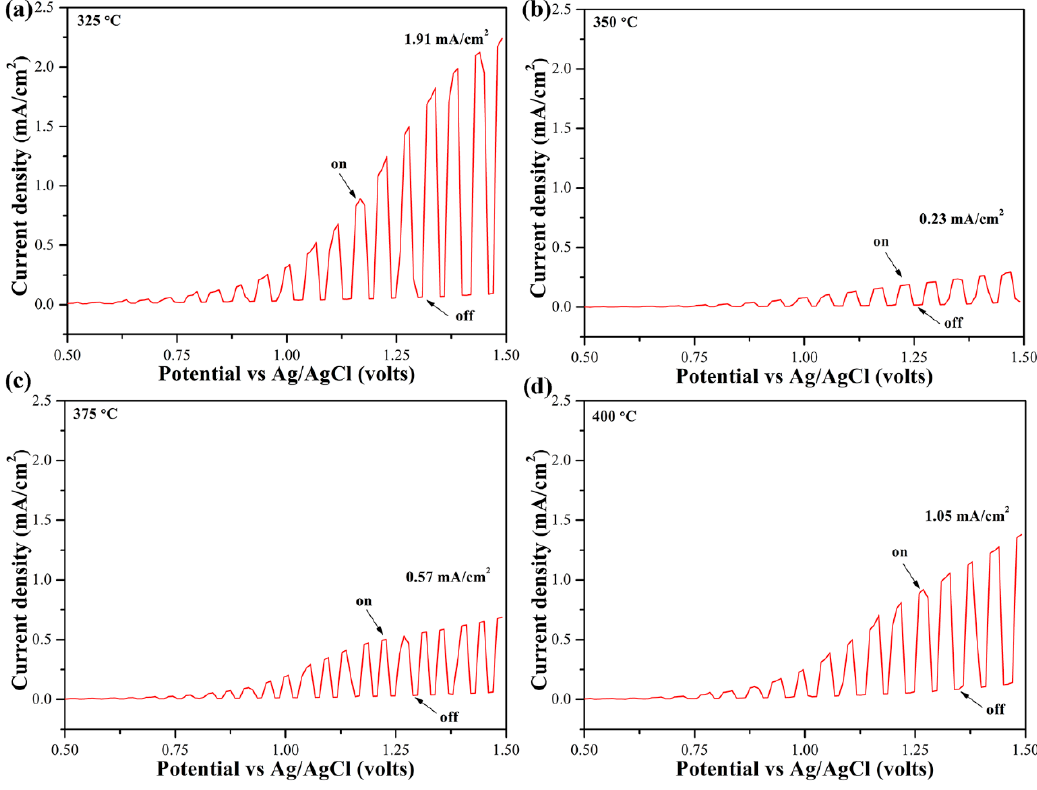
Figure 6. Photocurrent-potential response curves of Te-Sb 2 Se 3 films with different annealing Photocurrent-potential response curves of Te-Sb 2 Se 3 films with di ff erent annealing temperatures: ( a ) 325, ( b ) 350, ( c ) 375, and ( d ) 400 °C. temperatures: ( a ) 325, ( b ) 350, ( c ) 375, and ( d ) 400 ◦